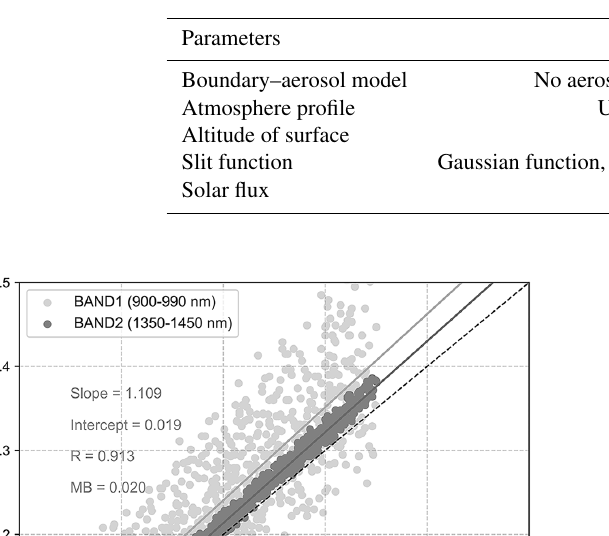
Table 2. The input parameters to the MODTRAN model used in this work.